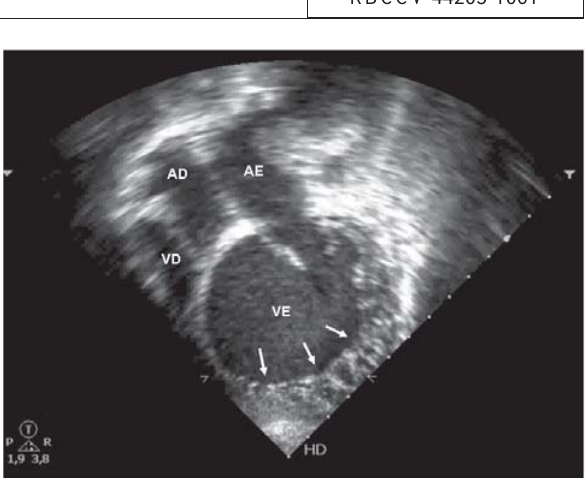
Fig. 1 – Corte apical quatro câmaras demonstrando o